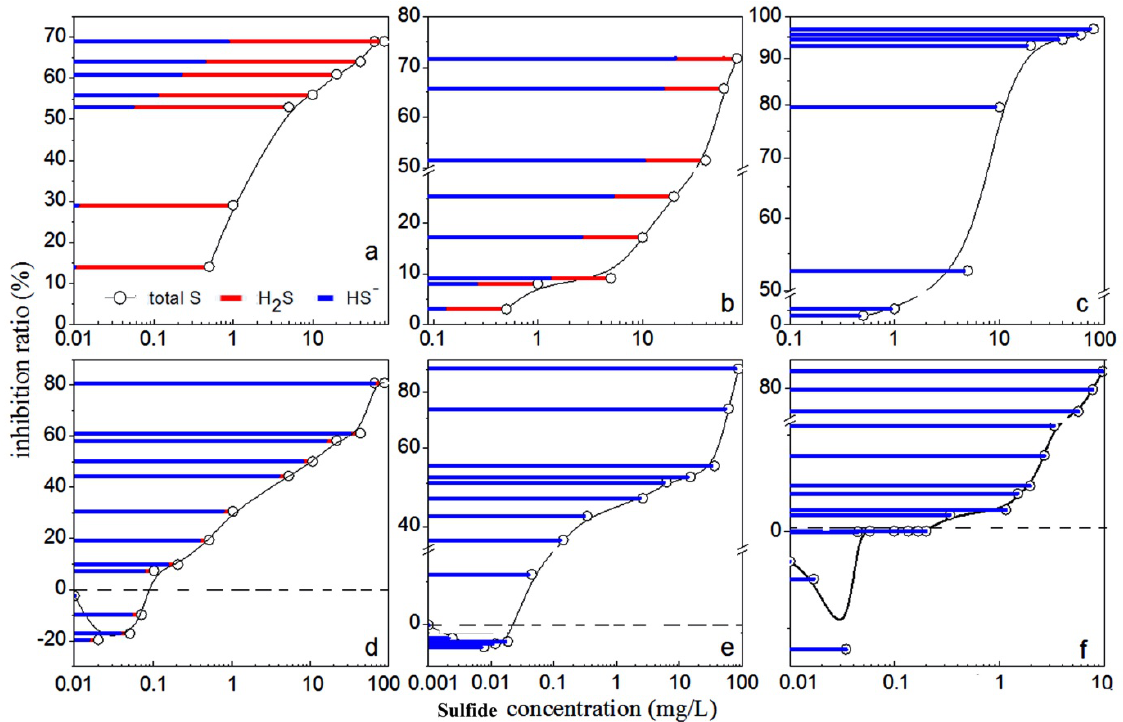
Figure 2. The relationship between the inhibition ratio and sulfide concentration in various pH media: ( a ) pH 6; ( b ) pH 6.5; ( c ) pH 10; ( d ) pH 7.4; ( e ) pH 8; and ( f ) pH